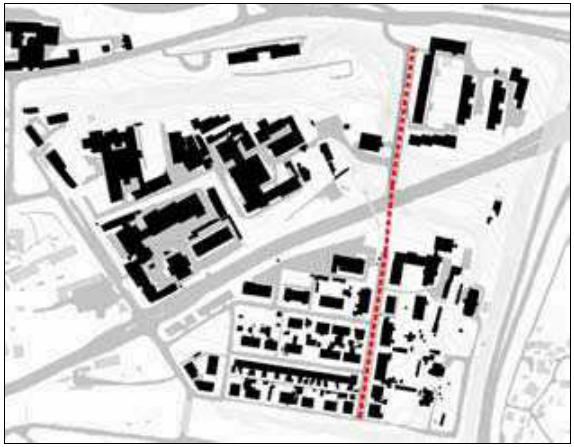
Fig. 7. realization of Vitebskas street (author‘s